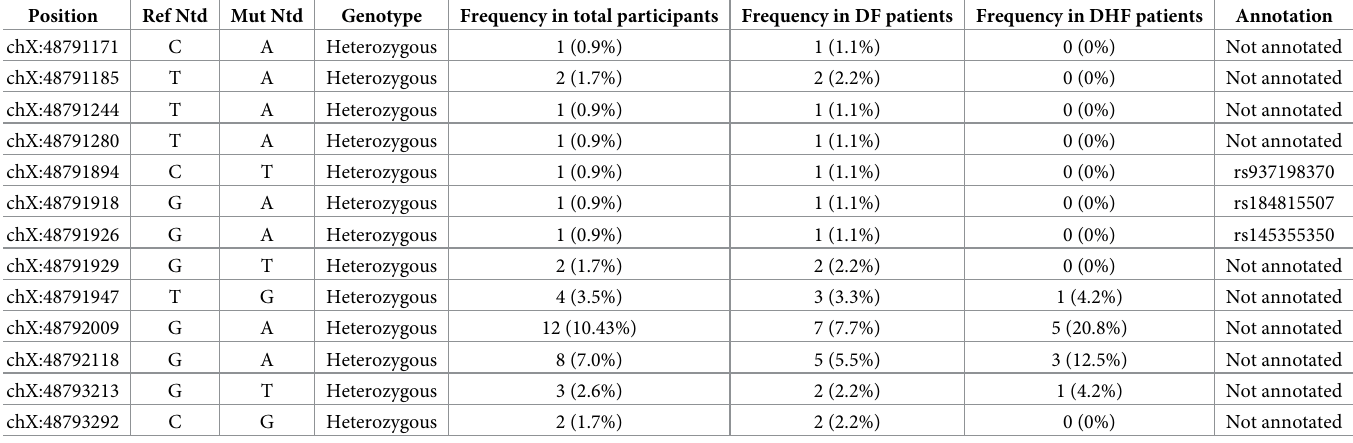
Table 2. Variations in the exonic regions of GATA1 along with their respective frequency distribution in total patients, patients with DF and DHF as well as anno- tation in database. Position Ref Ntd Mut Ntd Genotype Frequency in total participants Frequency in DF patients Frequency in DHF patients